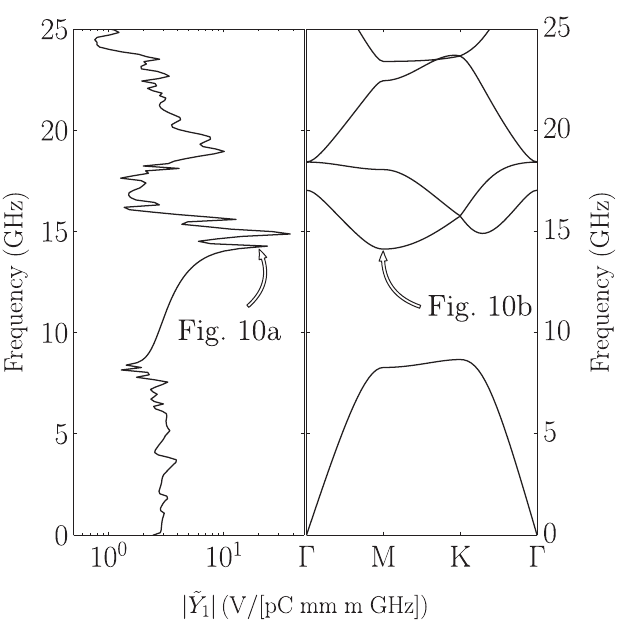
9. The left plot shows a zoomed-in view of the troublesome part of the transverse dipole impedance (from Fig. 8). The right plot is the 2D TM band diagram for the triangular lattice of sapphire discs. The annotated peak in the impedance is at the same frequency as the M point of the second band (also see the mode patterns in Fig. 10). This correlation supports the idea that low- v modes pose a problem for